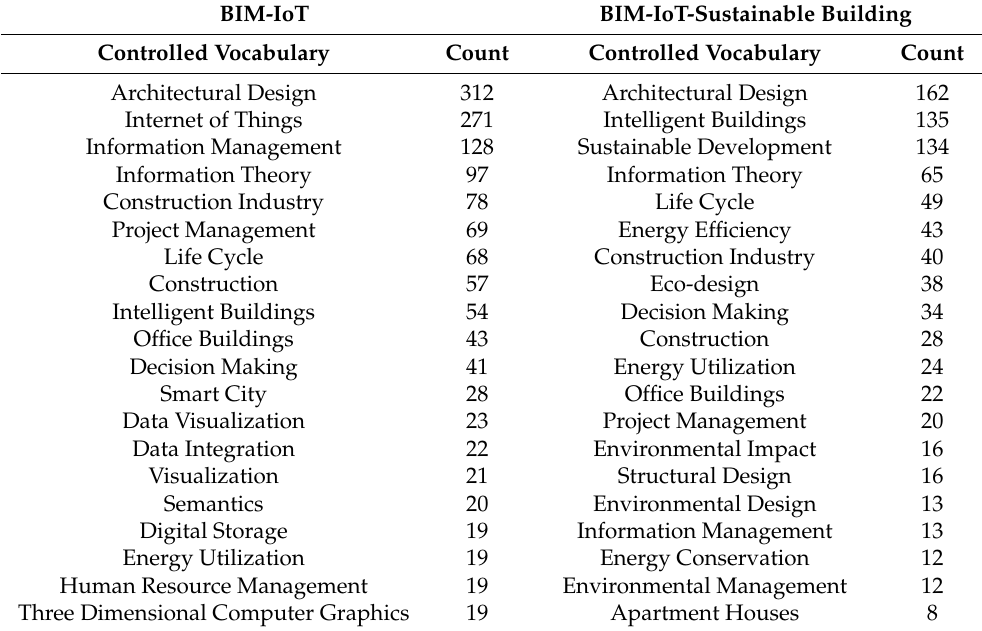
Table 3. Top 20 controlled terms under the topic BIM–IoT (left) and BIM–IoT-sustainable building (right) in the Engineering Index (EI) Compendex core database (generated by the authors). BIM-IoT BIM-IoT-Sustainable Building Controlled Vocabulary Count Controlled Vocabulary Count Architectural